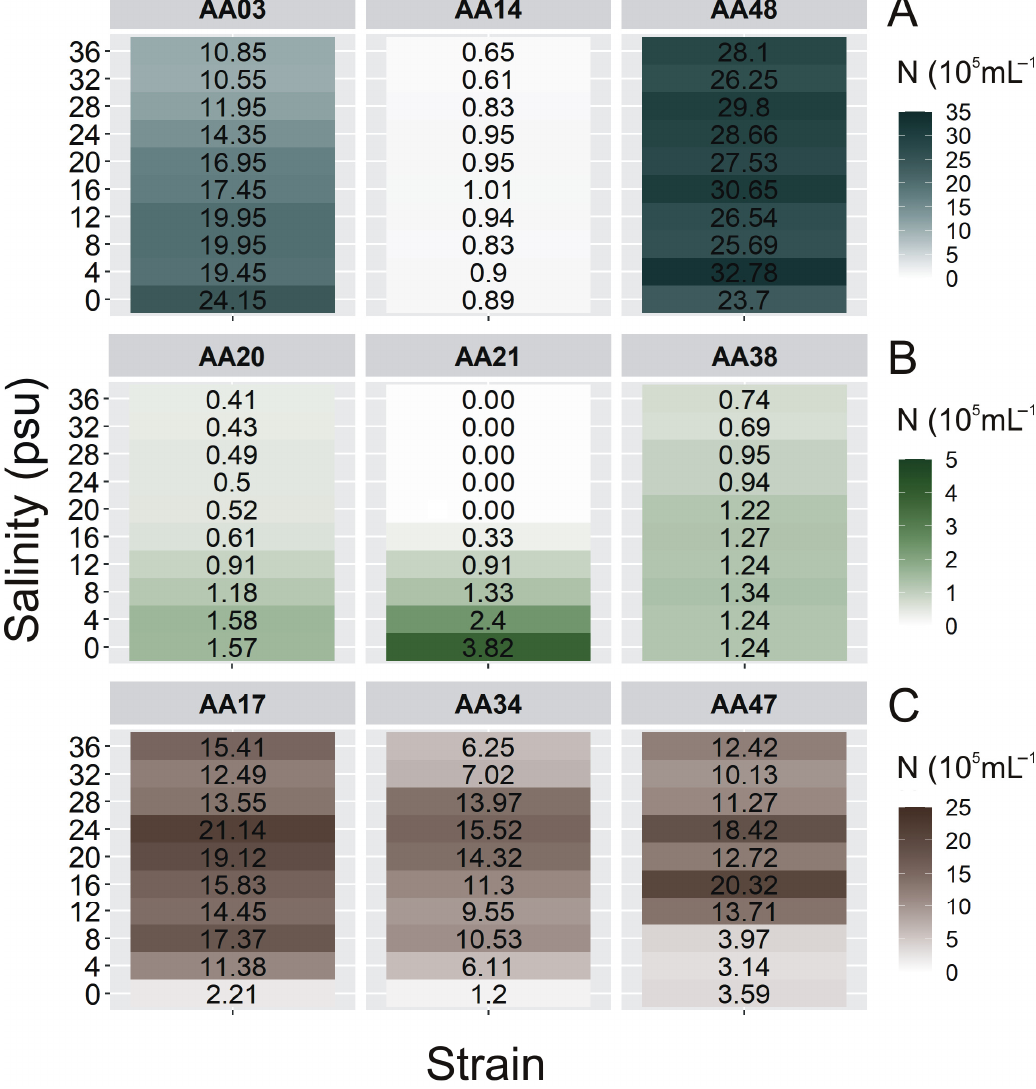
Figure 4. The number of cells (N × 10 5 mL –1 ) obtained after 7 days of experiment for airborne cyanobacteria ( A ): Nostoc sp. (CCAA 03), Synechococcus sp. (CCAA 14), Aphanothece sp. (CCAA 48), green algae ( B ): Oocystis sp. (CCAA 20), Coccomyxa sp. (CCAA 21), Kirchneriella sp. (CCAA 38), and diatoms ( C ): Nitzschia sp. (CCAA 17), Amphora sp. (CCAA 34), Halamphora sp. (CCAA 47) under different salinity conditions.